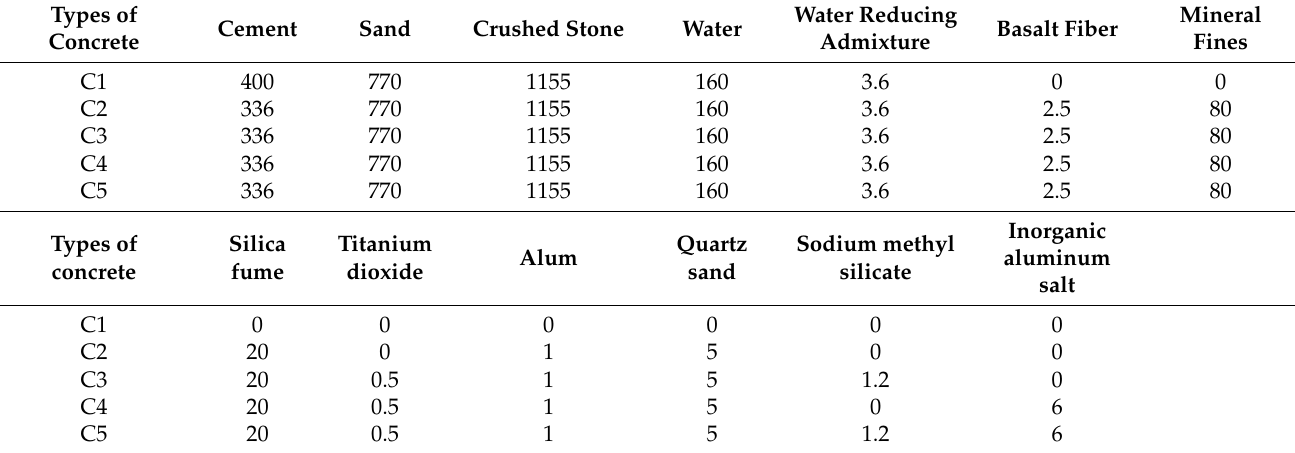
Table 1. Concrete mix ratio (unit: kg/m 3 ).